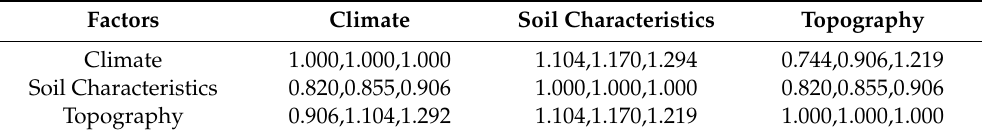
Table 5. Triangular fuzzy number pairwise comparison matrix for the main factors.